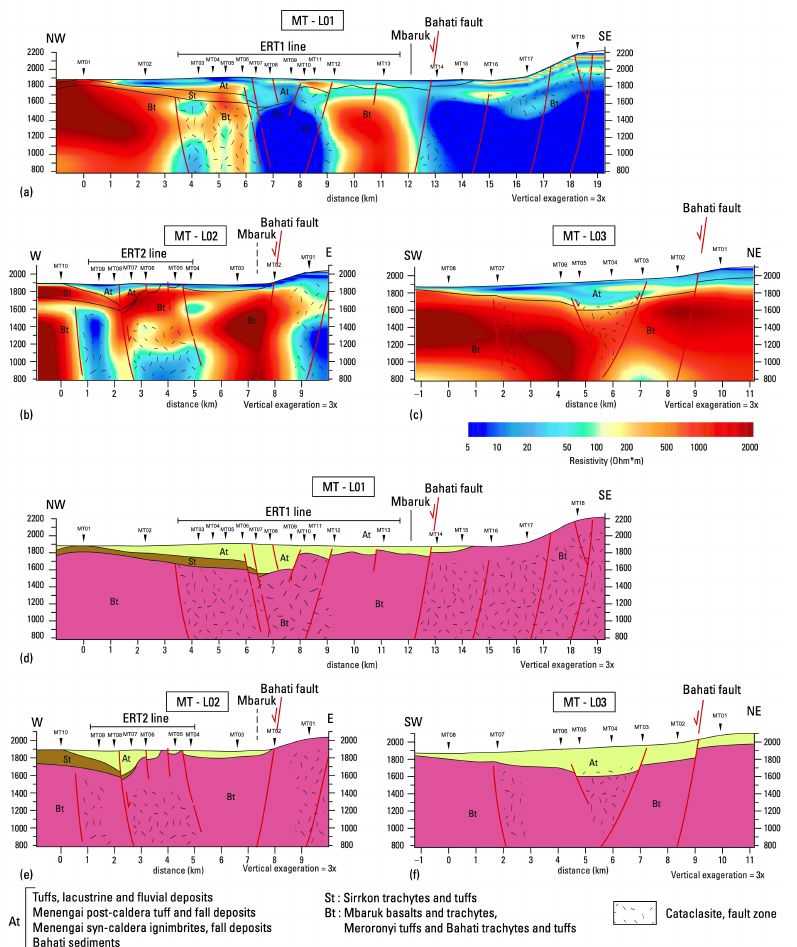
Figure 11. ( a – c ) Cross section based on magnetotelluric (HSAMT) and HVSR data. ( d – f ) Geological cross-section. See Figure 5 for location. Sections include data from ERT1 and ERT2 lines (Figure